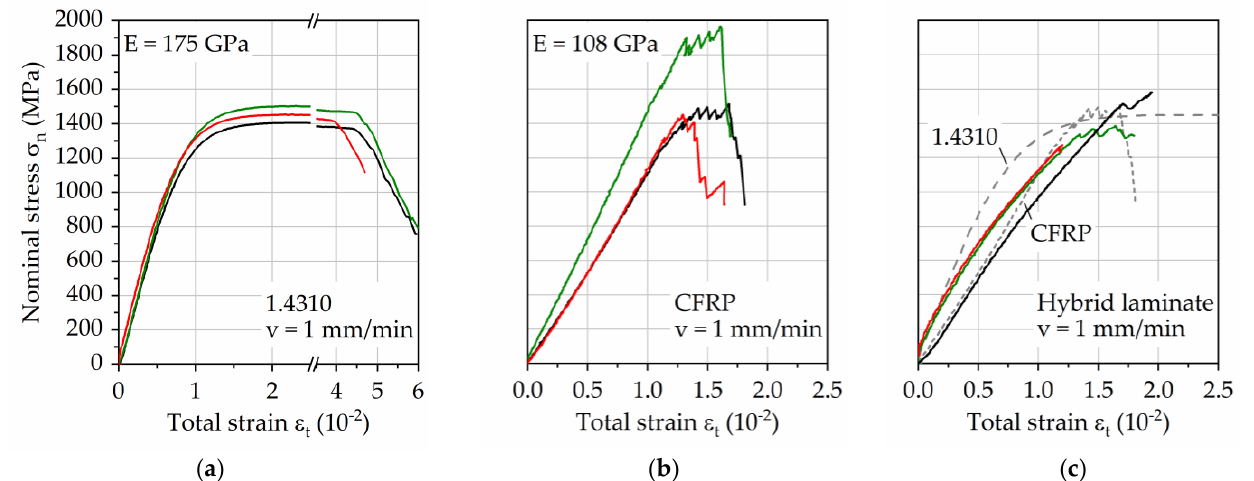
Figure 6. Stress–strain curves of ( a ) 1.4310, ( b ) carbon fiber reinforced PA 6, and ( c ) both combined as hybrid laminate in a 1/2-configuration. Each color represents one specimen tested. For the hybrid material the stress–strain curves of the constituents are given for comparison in the diagram.